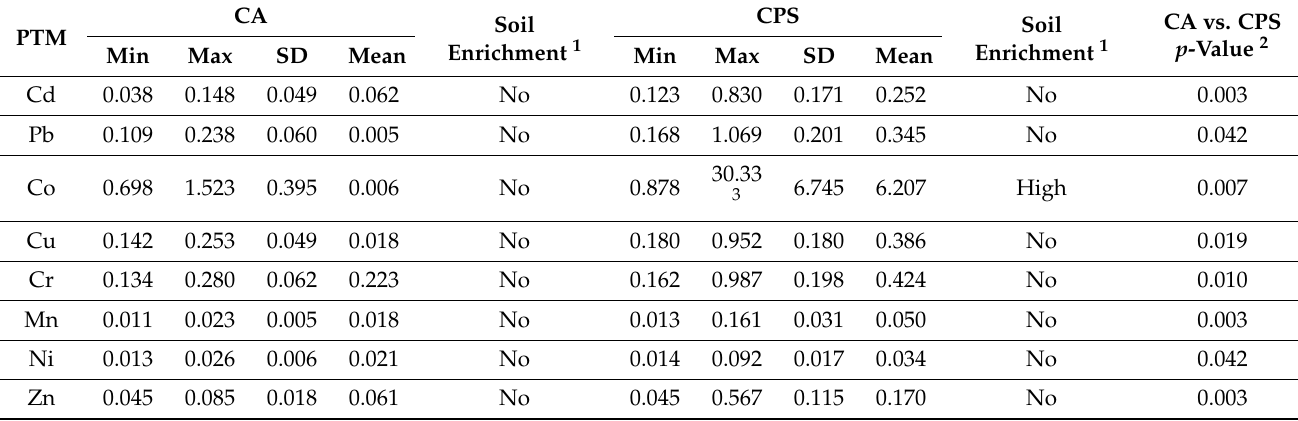
Figure 3. Boxplot of Geoaccumulation Index (Igeo Index) for each accessed PTM, by sampled environments: Cement Plant Surroundings (CPS) and Control (CA). Wilcoxon tests p -values (CPS vs. CA) were described on the lower right corner. Different letters above boxplots represent significant differences in compared mean values by Wilcoxon tests. Table 3. Calculated Enrichment Factor (EF) of PTM from CA and CPS soil samples.